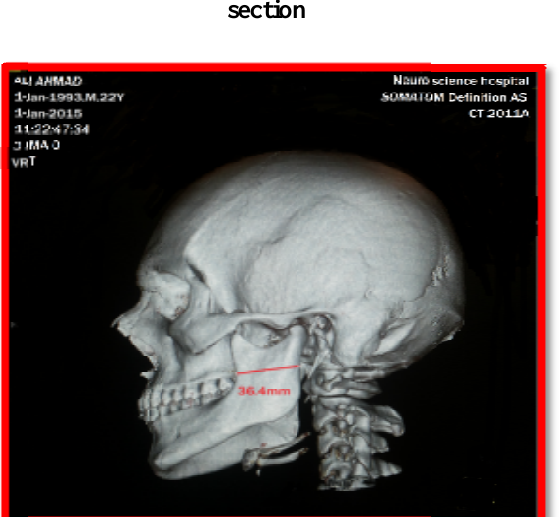
Figure2:Linear measurements of condylar height (Min MRB) by 3D